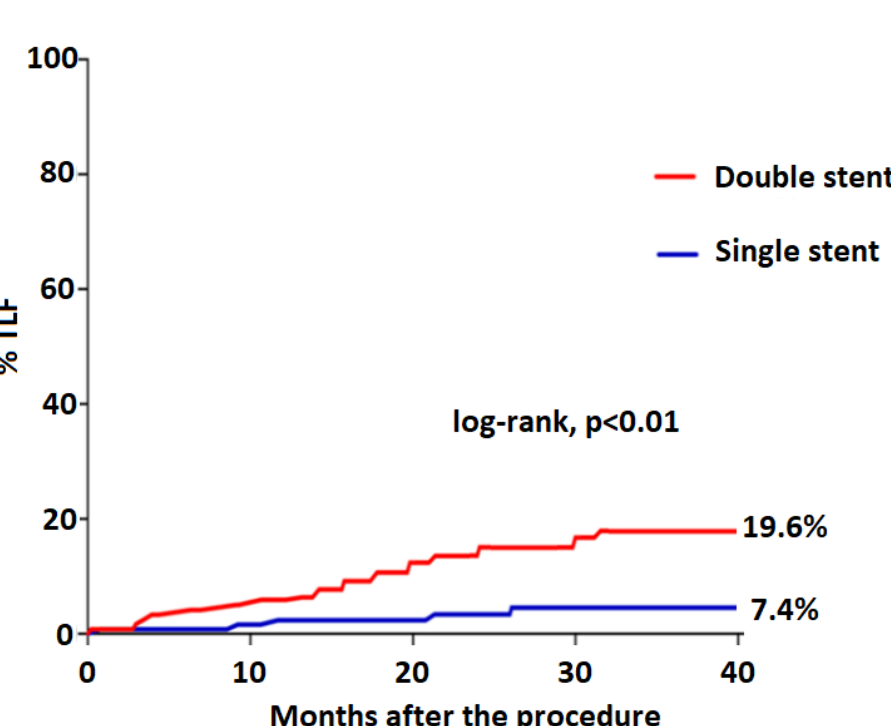
Figure 1. Kaplan–Meier analysis (log-rank) indicated that patients with a double stent had a high occurrence of TLF compared to those treated with a single stenting approach.